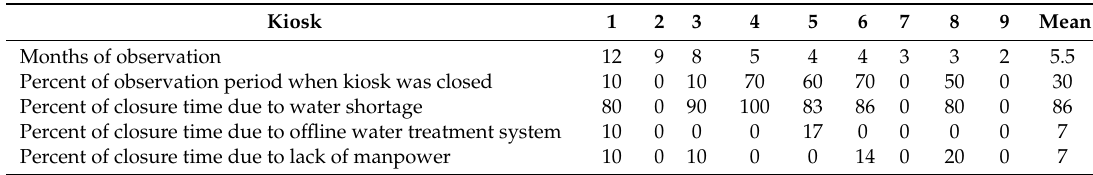
Table 2. Water Kiosk Operation and Closure, and Reasons for Closures at Nine Health Care Facilities in Rural Rwanda,